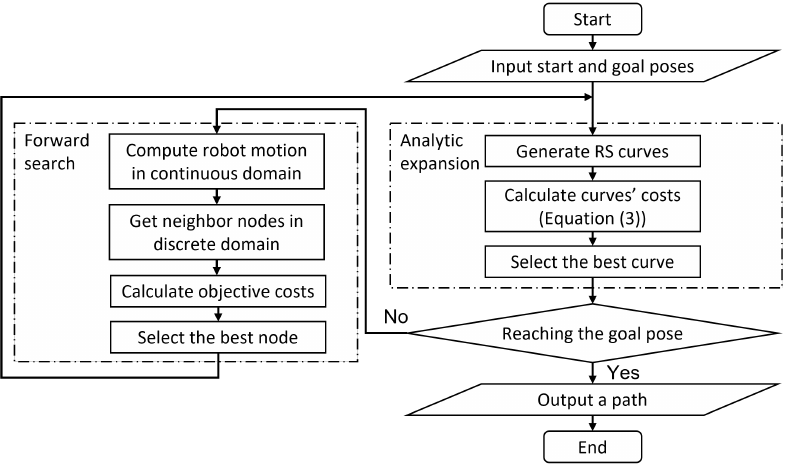
Figure 4. Flowchart of the implemented method.